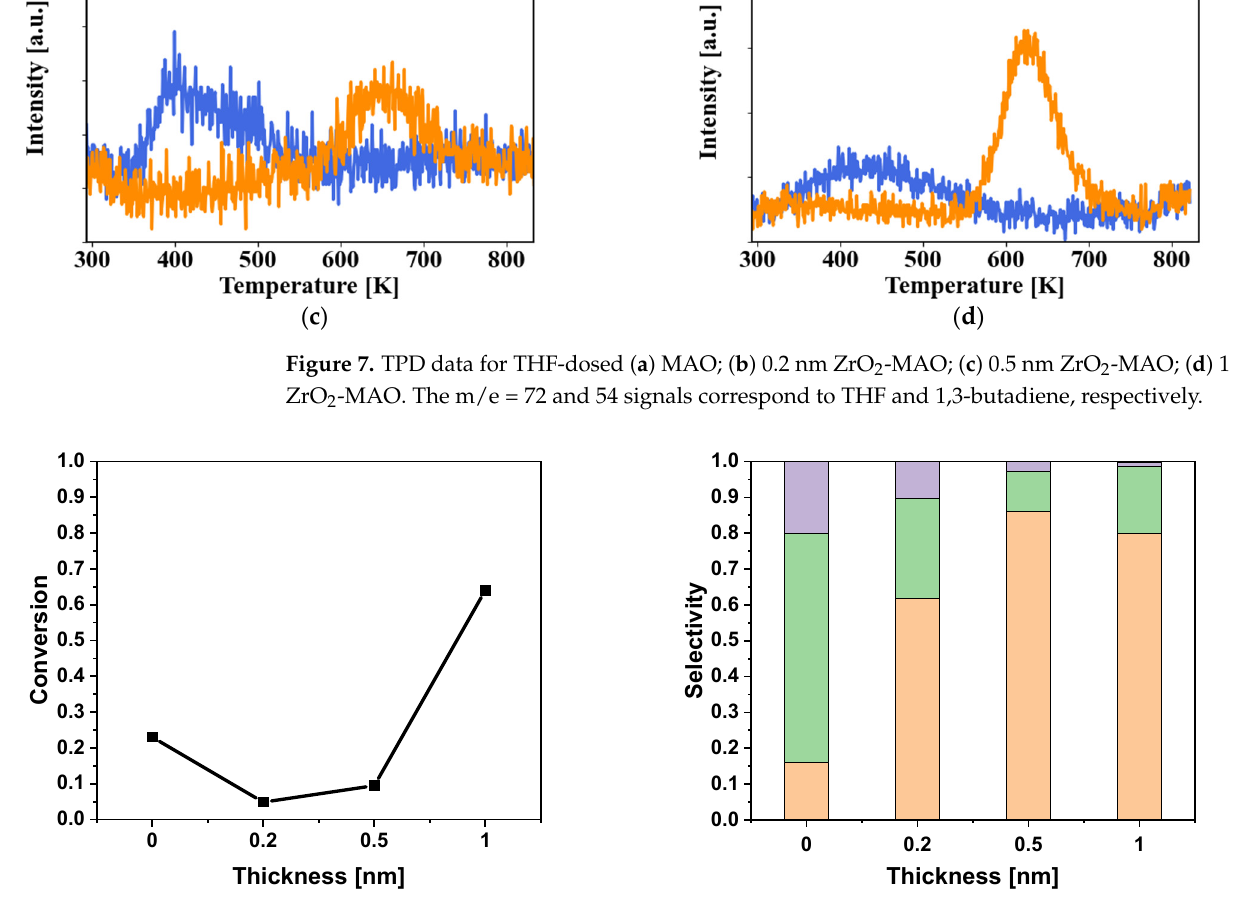
Figure 7. TPD data for THF-dosed ( a ) MAO; ( b ) 0.2 nm ZrO 2 -MAO; ( c ) 0.5 nm ZrO 2 -MAO; ( d ) 1 nm ZrO 2 -MAO. The m/e = 72 and 54 signals correspond to THF and 1,3-butadiene, respectively.